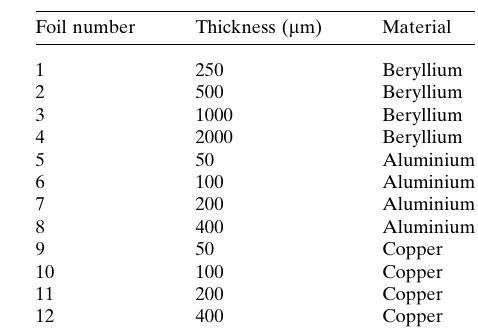
Table 2 List of absorption